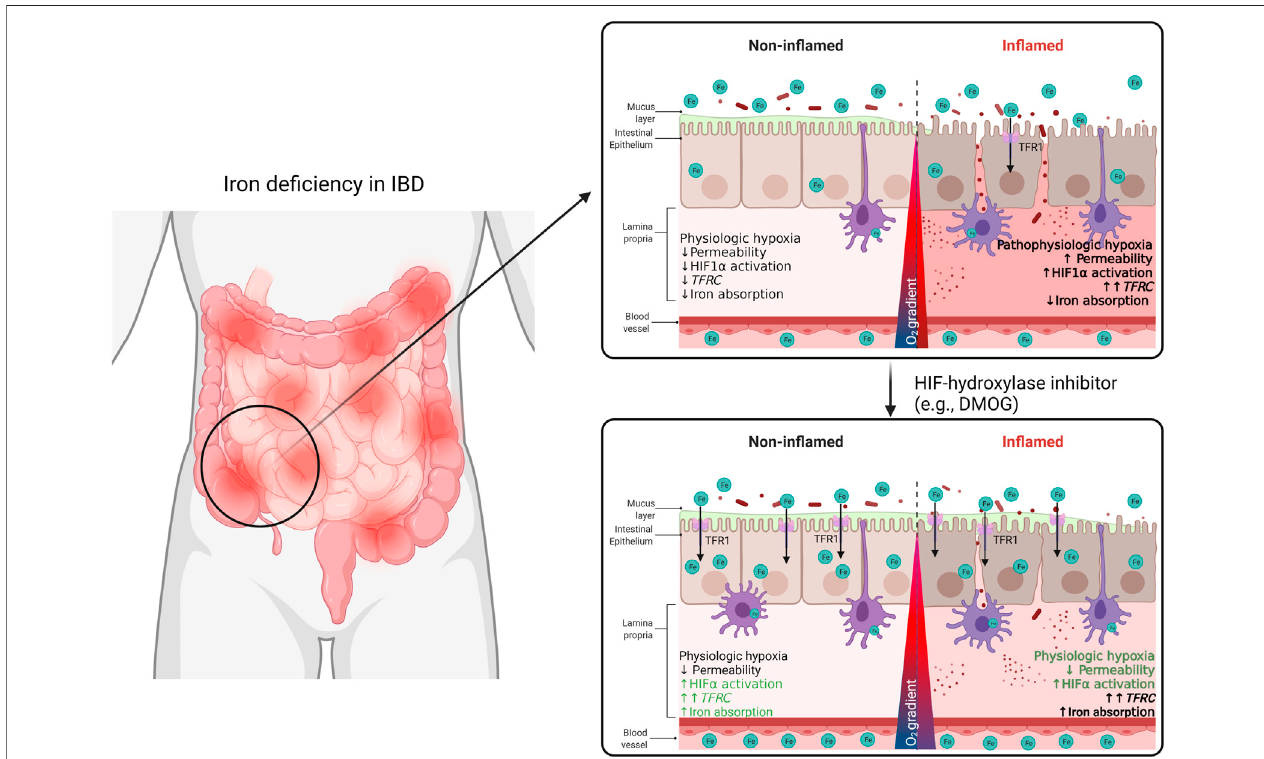
FIGURE 7 | In this study, we demonstrate a TFR1-HIF1 α axis may be a target of interest for the regulation of systemic iron homeostasis in the context of IBD. We describe a correlation between TFRC expression and HIF1 α pathway activation in the intestinal mucosa of IBD patients. This TFRC -HIF1 α axis is regulated by in fl ammation and systemic iron de fi ciency. Patients ’ responsiveness to iron supplementation may be improved with treatment with HIF1 α